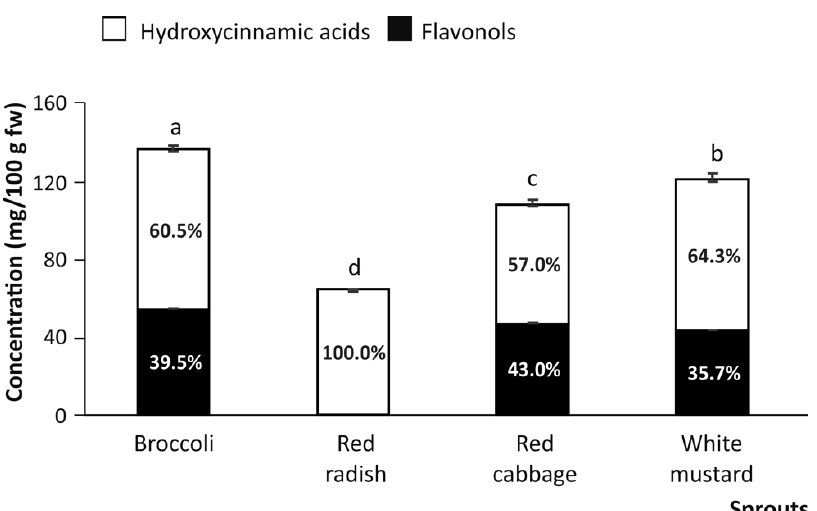
Figure 2. Total content of phenolic compounds (mg/100 g fw) in raw cruciferous sprouts with indi- cation of the percentage of flavonols and hydroxycinnamic acids contributing to the (poly)phenolic profile. Mean values ± SD (n = 3) with different lowercase letters are significantly different at p < 0.01 according to the analysis of variance (ANOVA) and Tukey’s multiple range test.